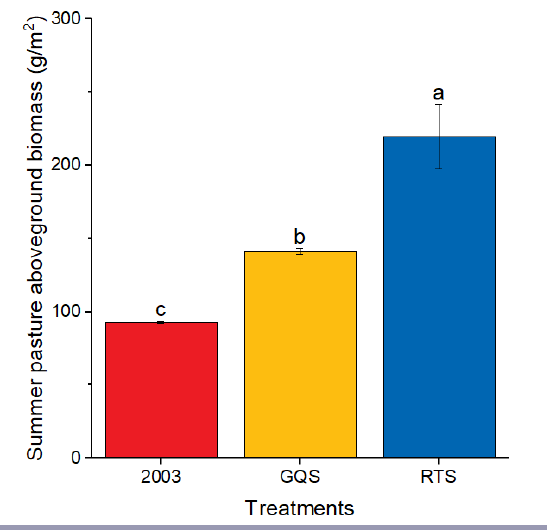
Fig. 4 . Soil organic carbon density (A) and nitrogen density (B) at 0-10 cm in the depth of summer pasture at baseline in